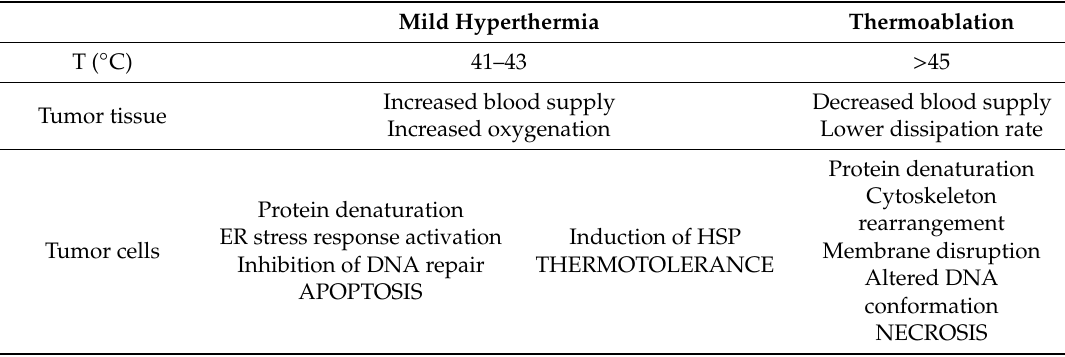
Table 2. Main characteristics and outcomes of mild hyperthermia and thermoablation